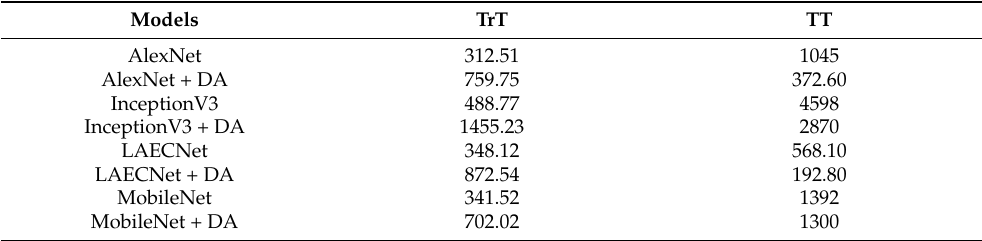
Table 7. Complexity comparison of various proposed networks using real and augmented data.